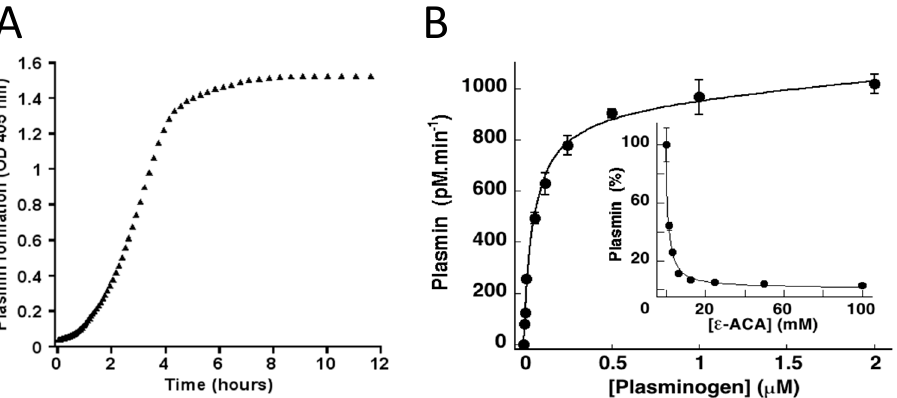
Figure 2. Plasminogen binding and activation on the membrane of mouse cortical neurons. ( A ) Kinetics of plasmin formation on the cell membrane upon incubation with a fixed amount of plasminogen. ( B ) Plasminogen binds to membrane receptors in a concentration-dependent manner and is converted to plasmin until saturation. The specificity of plasminogen binding to the terminal lysine residues of membrane receptors is confirmed by its inhibition in the presence of the lysine analogue ε -aminocaproic acid, ε -ACA (inset) [42,49,50].